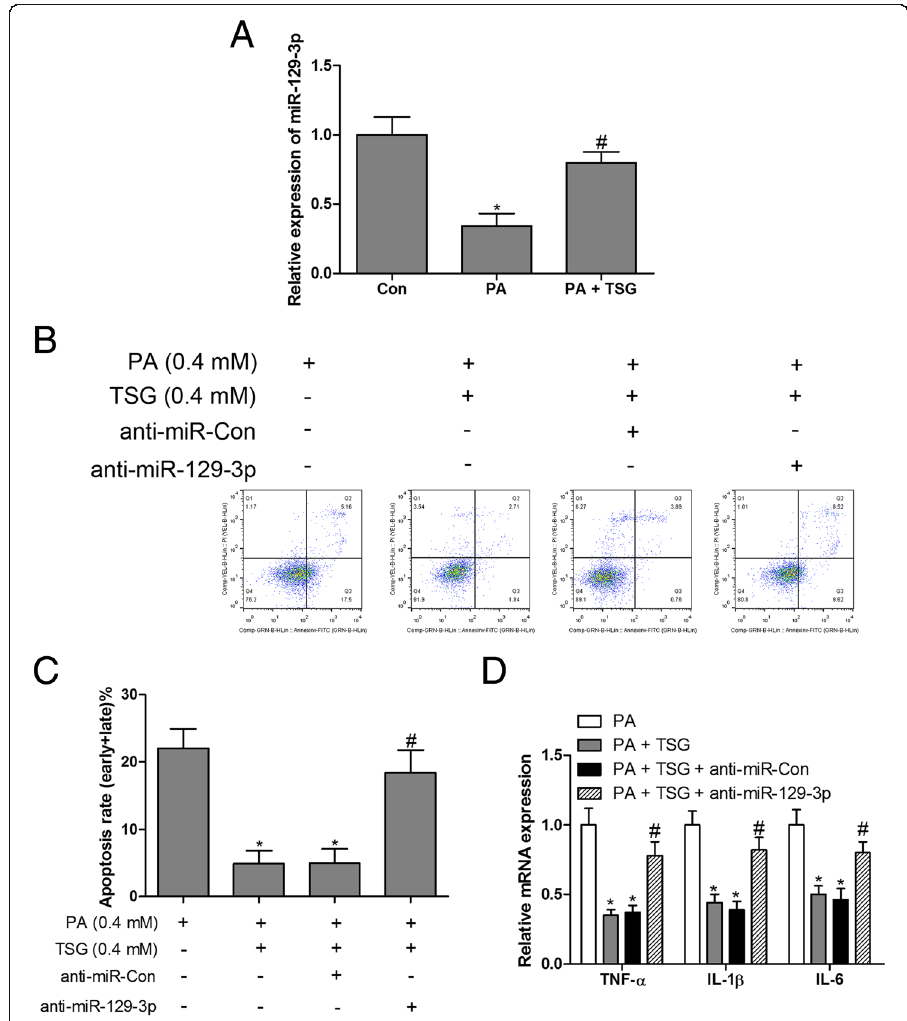
Fig. 4 miR-129-3p loss-of-function reversed the protective effects of TSG in PA-induced inflammation and apoptosis. Expression of miR-129-3p was measured by RT-qPCR in H9c2 cells treated with PA (0.4 mM) or PA (0.4 mM) + TSG (0.4 mM) for 48 h ( a ). H9c2 cells transfected with miR-129-3p inhibitors and treated with PA (0.4 mM) and TSG (0.4 mM) for 48 h, cell apoptosis was detected by flow cytometry ( b and c ); RT-qPCR was performed to measure the mRNA expression of TNF- α , IL-1 β and IL-6 ( d ). * P < 0.05 compared with control group; # P < 0.05 compared with PA or PA + TSG group. n = 3 in each